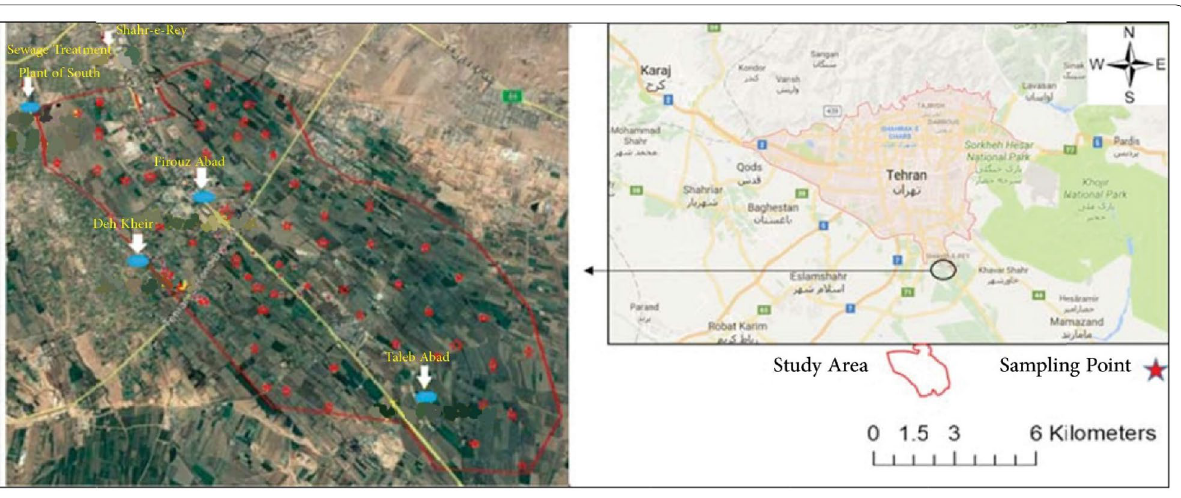
Fig. 1 The study area and sampling